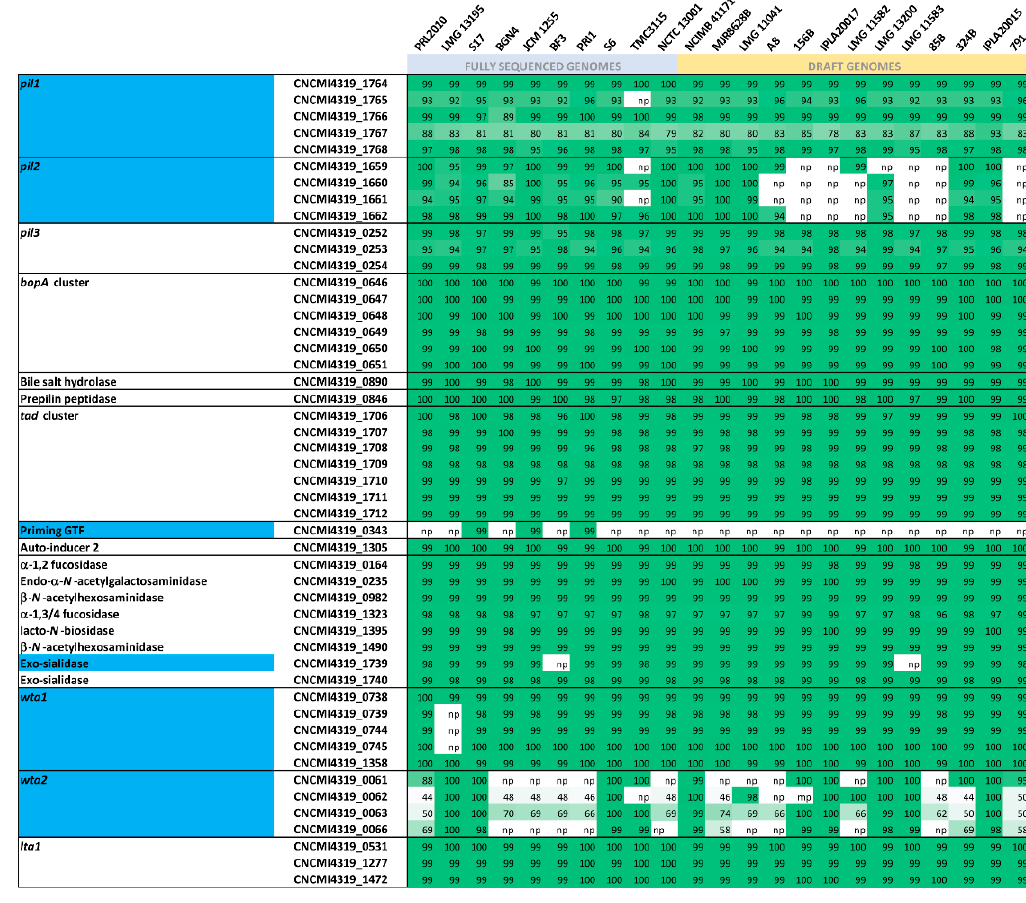
Figure 2. Adhesion and host-interacting features of B. bifidum CNCM I-4319. Heatmap showing the distribution of B. bifidum CNCM I-4319 gene clusters which are predicted to encode probiotic properties and / or responsible for host-interaction and gut colonisation. The green scale indicates sequence similarity (BLASTP alignment) of each identified CNCM I-4319 gene with its homologous in sequenced B. bifidum strains. Highlighted in blue represent clusters that are found to be variably distributed across members of the B. bifidum species.